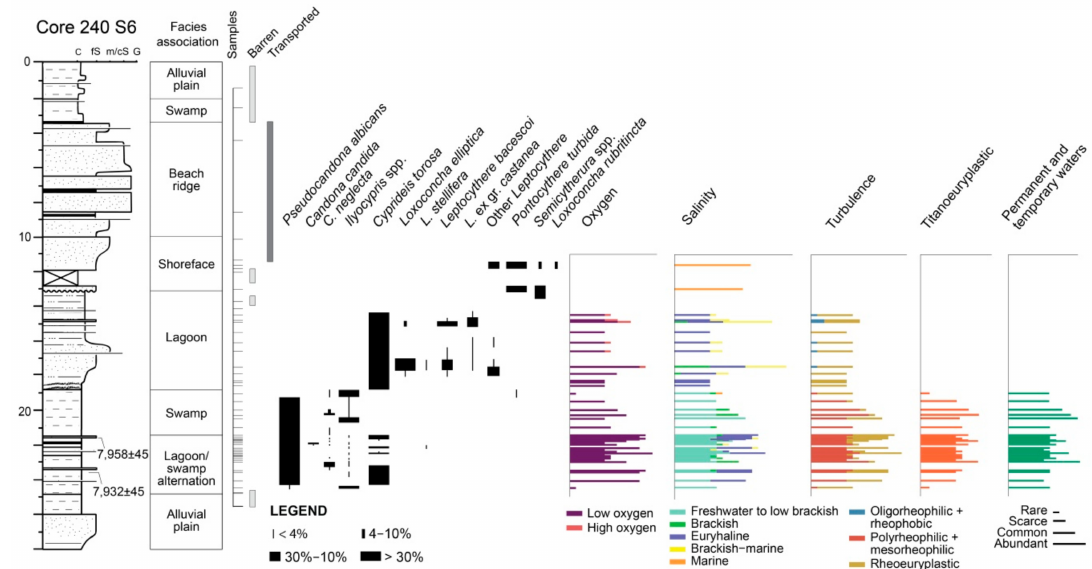
Figure 7. Vertical distribution patterns of benthic ostracods in core 240 S5. Relative abundances of taxa and ecological groups, reported as abundances categories, are shown. Samples with no or transported ostracod valves are